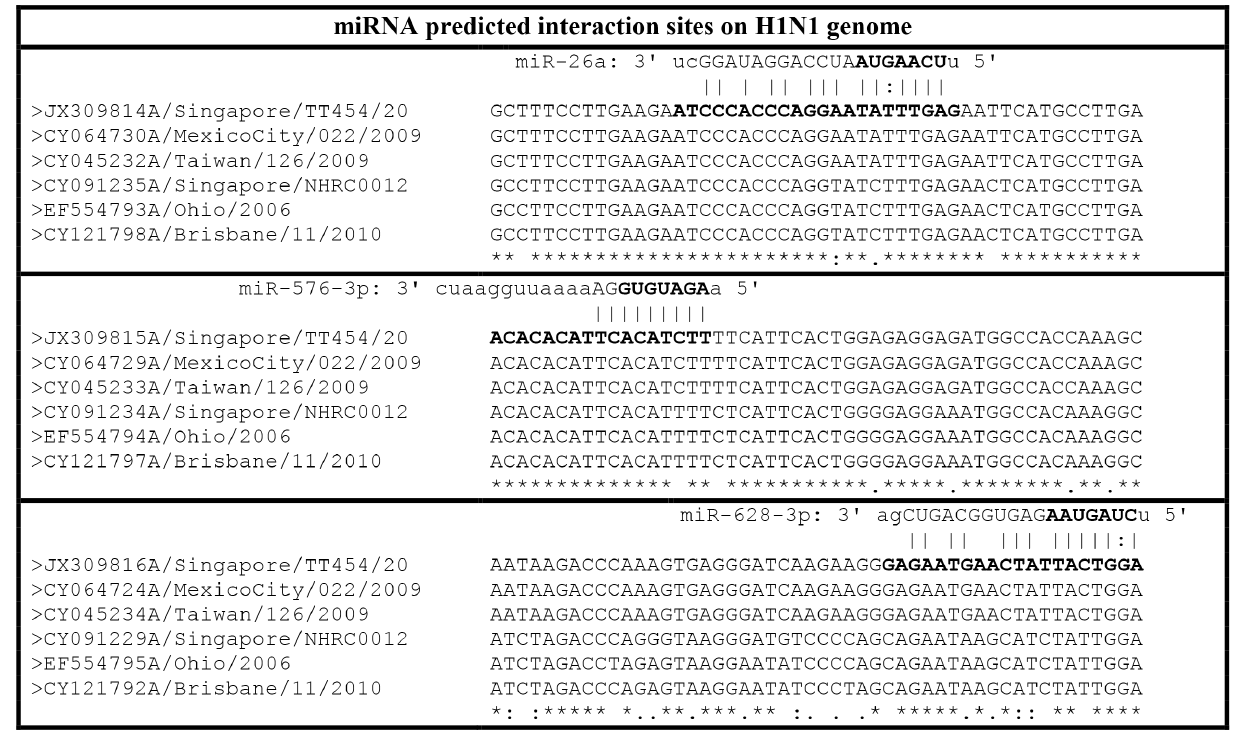
Figure 2. Predicted miRNA interaction sites on the H1N1 genome. The predicted miRNA interaction site in the H1N1 genome (JX309814/5/6A/Singapore/TT454/20; CY064724/29/30A/MexicoCity/022/2009; CY045232/3/4A/Taiwan/126/2009) and the miRNA seed regions are highlighted in bold. The sequences were obtained from NCBI. The corresponding accession numbers of the segments are denoted by the first eight letters/numbers in the label. The corresponding segments of H3N2 sequences (CY091229/24/35A/Singapore/NHRC0012; EF554793/4/5A/Ohio/2006; CY121792/7/8A/Brisbane/11/2010) are also shown. * refers to nucleotides which are fully conserved: indicates strong conservation within H1N1 and H3N2 whereas. indicates weak conservation within H1N1 and